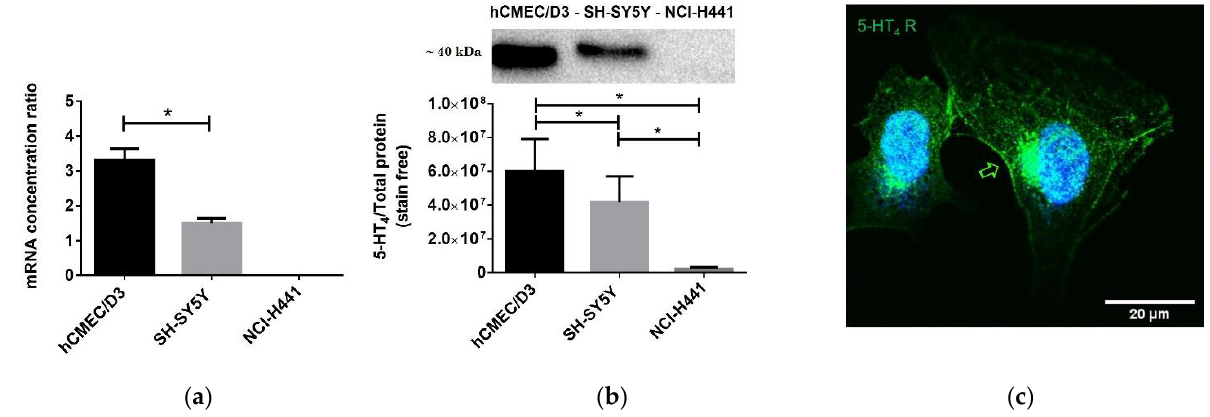
Figure 3. 5-HT 4 receptor expression in hCMEC/D3 cell line: ( a ) real time qPCR quantification of 5-HT 4 receptor mRNA. ( b ) Western blot analysis of 5-HT 4 receptor expression. The mRNA and proteins extracted from human neuroblastoma cell line (SH-SY5Y) and lung papillary adenocarcinoma cell line (NCI-H441) were used as positive and negative controls of 5-HT 4 receptor expression, respectively. ( c ) Photomicrographic illustration of the 5-HT 4 receptor immunofluorescence analysis in hCMEC/D3. The immunoreactivity of the 5-HT 4 receptor exhibits a strong distribution in the cytoplasm and on the membrane or perimembrane area. Histograms represent mean ± SEM from three independent experiments. * p < 0.05.